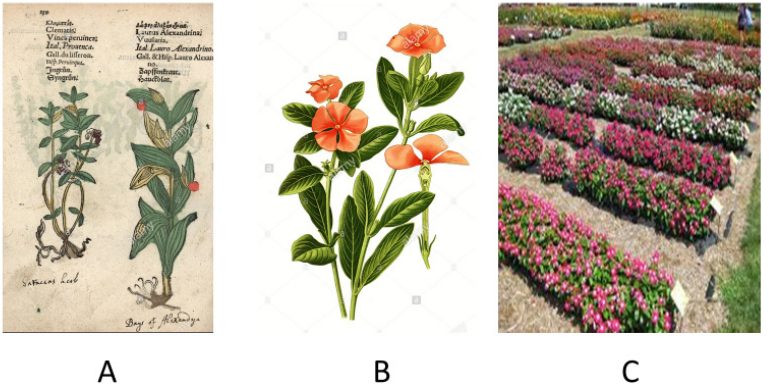
Figure 1. The plant of Vinca rosea . ( A , B ) Antique hand-drawn pictures of the plant Vinca rosea . These images are re-elaborated from Adam Lonicer’s Kräuterbuch or Herbal Handbook published in Frankfurt (Germany) in 1557. Adam Lonicer, also known as Adam Lonitzer or Adamus Lo- nicerus (1528–1586) was a German botanist, noted for his 1557 revised version of Eucharius Rösslin’s herbal (Adam Lonicer: Kräuter-Buch, 1703). However, despite the beautiful and sugges- tive character of these xylographic pictures, according to some historians and naturalists this work